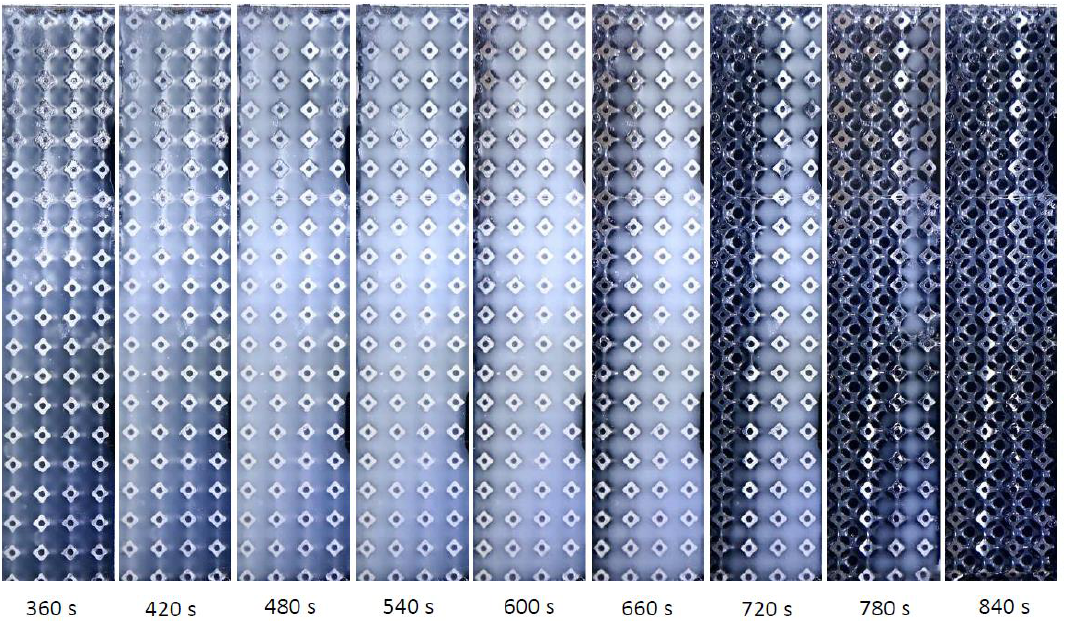
Figure 6. Melting fronts for the paraffin RT42 with an imposed heat flux of 10 kW m − 2 .